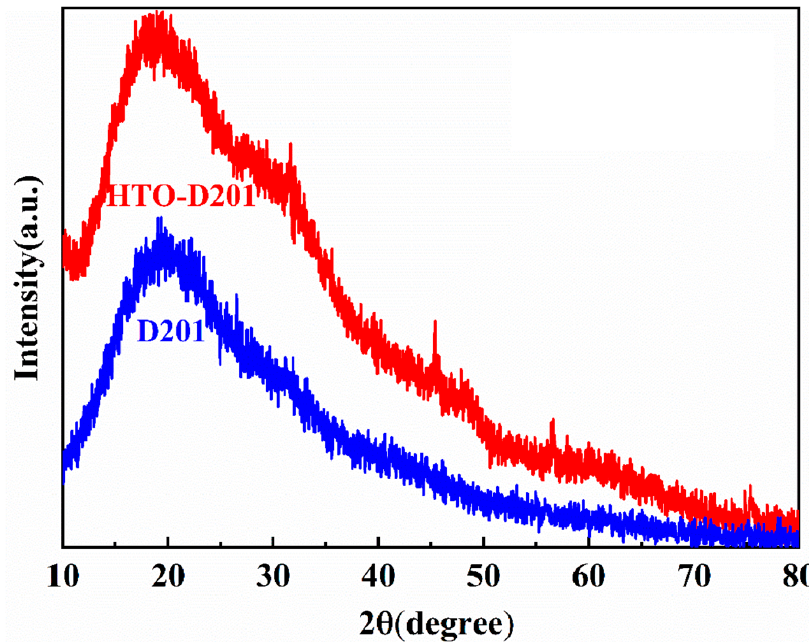
Figure 4. XRD patterns of D201 and HTO-D201. Table 1. Comparison of basic properties of D201 and HTO -D201.